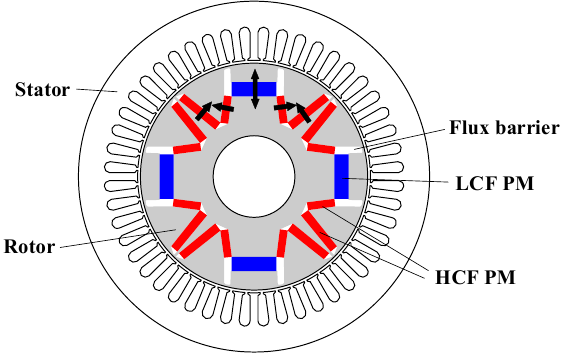
Figure 28. W ‐ type LCF PM with I ‐ type HCF PM in VFM machine [78].